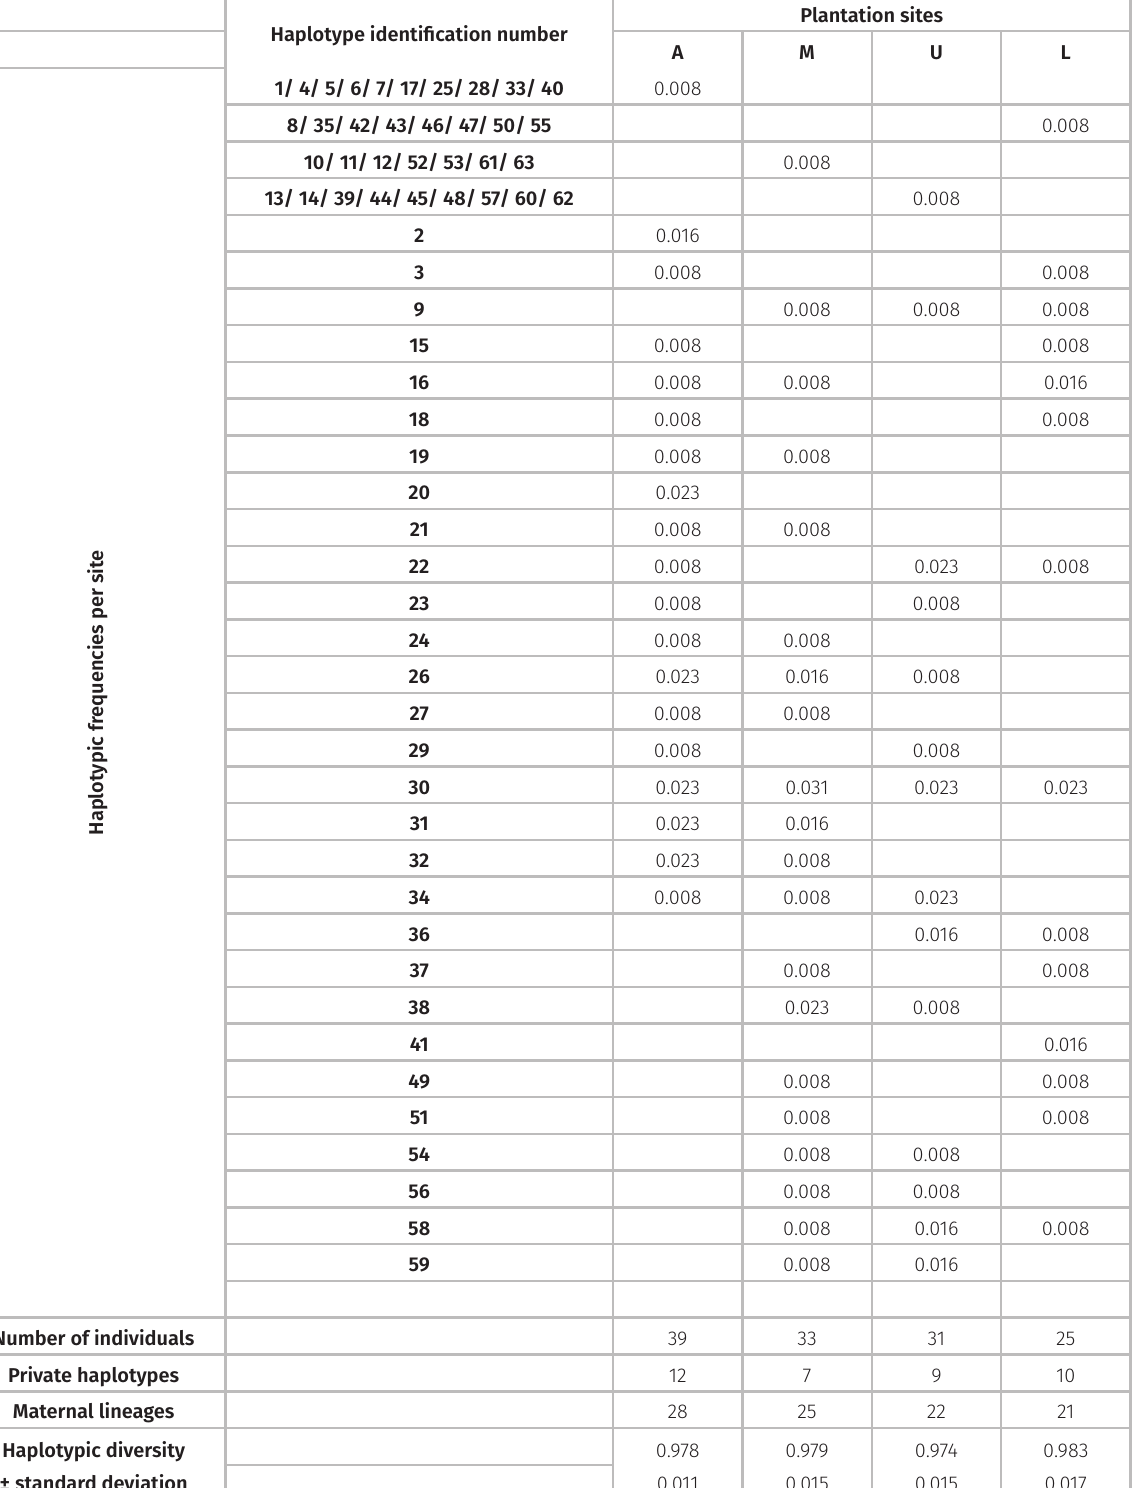
Table VI. Frequencies of chloroplastidic haplotypes per plantation site and other statistics. Haplotype identification